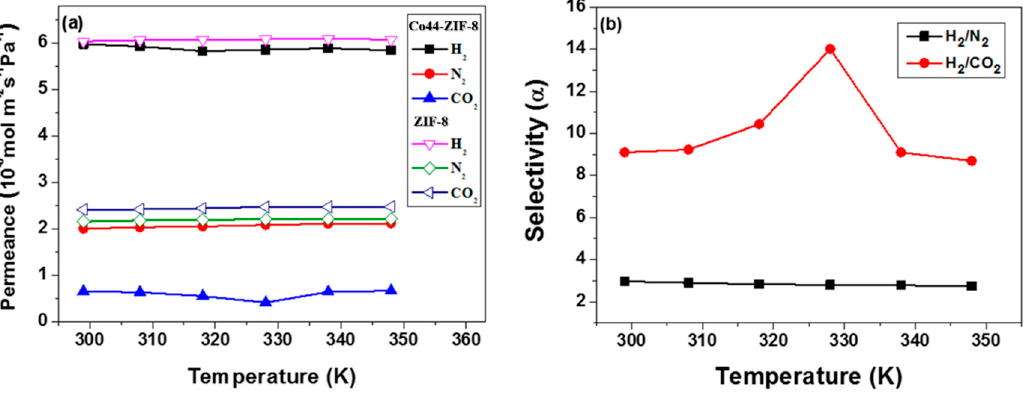
Figure 11. Single component gas permeation of H 2 , N 2 , and CO 2 results for ( a ) ZIF-8 and Co44-ZIF-8 membranes, and ( b ) ideal selectivities as functions of temperature.